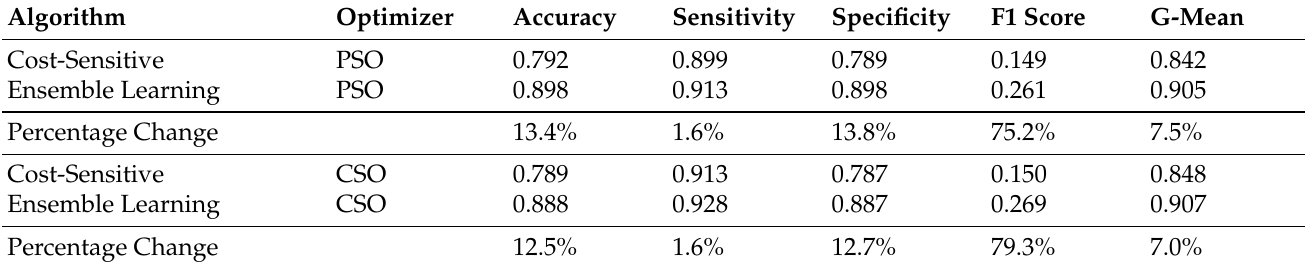
Table 14. A comparison between the results of the evaluation metrics from the cost-sensitive MHOANN and those from the cost-sensitive MHOANN within the majority voting ensemble learning system using the dataset of Polish